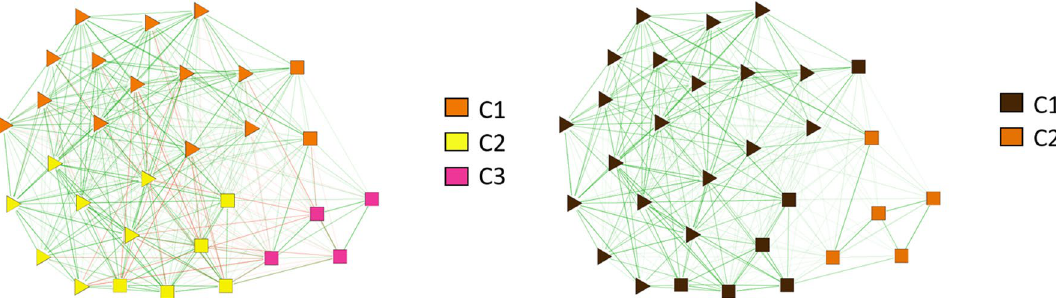
Figure 8. Community analysis of group B in wave 1 taking into account both positive and negative links (left) and only positive links (right). Nodes belonging to each community are marked by color as indicated in the plot. Friendship links are drawn in green, whereas enmity links are drawn in red. The shape of each node represents its gender: triangles correspond with girls and squares with